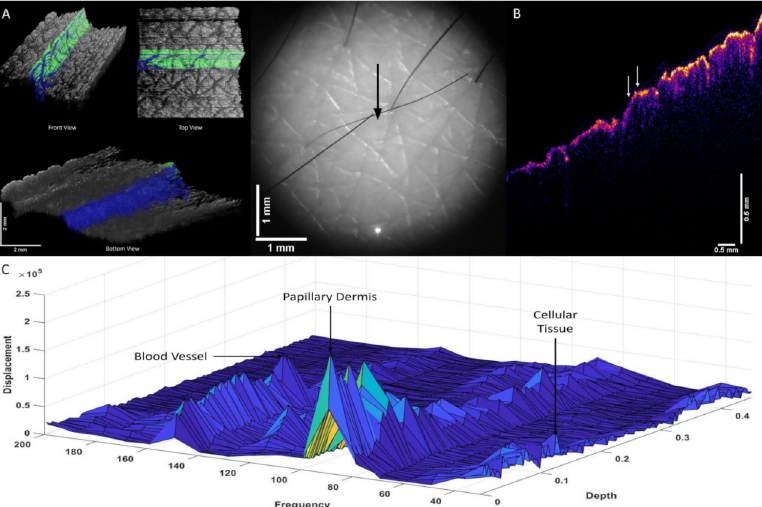
Figure 2. Three-dimensional construction ( A ) of normal skin from a 71-year-old subject illustrating the location of dermal cells (green) and papillary collagen (blue) as well as camera image of the skin. The arrow in the camera image (center) shows the location where the VOCT data were collected, and the OCT image of the skin cross-section is shown in ( B ). ( C ) shows a 3D plot of weighted displacement versus frequency and depth illustrating the location of skin cells, papillary collagen, and blood vessels. Note that the peaks at about 50 Hz (cells), 100 Hz (dermal collagen), and 150 Hz (blood vessels) are found in normal skin. The cells are found primarily in the epidermis and papillary dermis, and the dermal collagen and blood vessels are found in the papillary dermis. The 3D plot of weighted displacement versus frequency versus depth (Figure 2C) was constructed from volume scan data, weighted displacement versus depth measurements, and image pixel intensity versus depth plots.